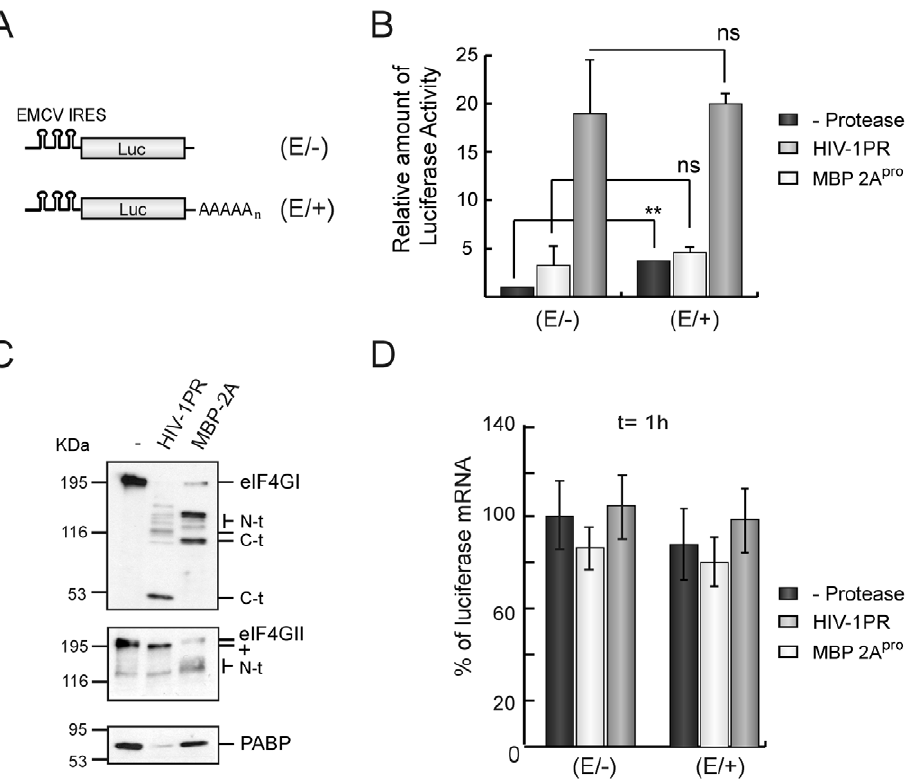
Figure 5. Effects of HIV-1 PR on translation of polyadenylated EMCV-IRES containing mRNAs in HeLa extracts. HeLa extracts were treated with 20 ng of HIV-1 PR or 1 m g of MBP-2A pro for 30 min. HeLa extracts were then programmed with 50 ng of (E/ 2 ) or (E/ + ) luc mRNAs. The samples were analyzed 1 h after the addition of luc mRNAs. A) Schematic representation of (E/ 2 ) and (E/ + ) luc mRNAs. B) Relative amounts of Luc activity. SDs were determined from three measurements of two independent experiments. *P , 0.05; **P , 0.01; ns, non-significant. C) eIF4GI, eIF4GII and PABP were analyzed by western blot. D) In parallel, after 1 h of translation reaction, total RNA was isolated from each sample and quantified by real-time RT-PCR. The relative levels of luciferase mRNAs were